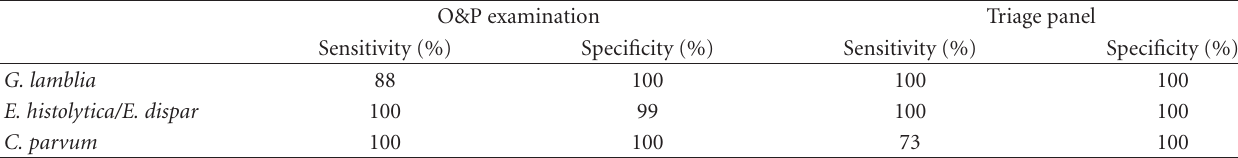
Table 2: Sensitivity and specificity results for the Triage Micro Parasite Panel and O&P